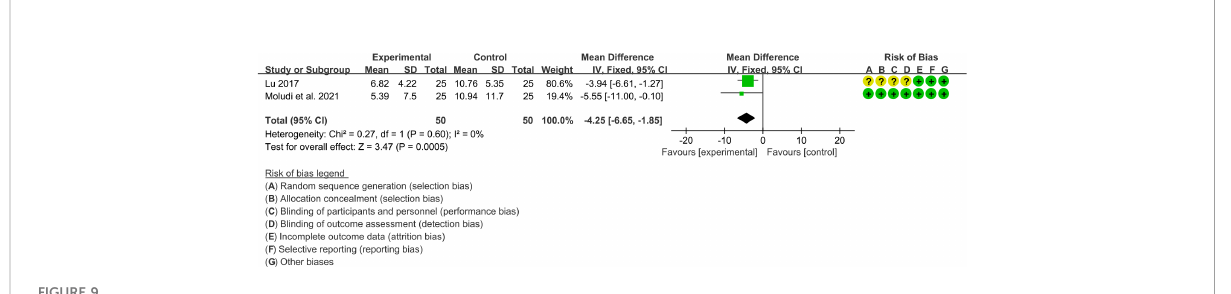
FIGURE 9 The results of PASI (CI, con fi dence interval; SD, standard